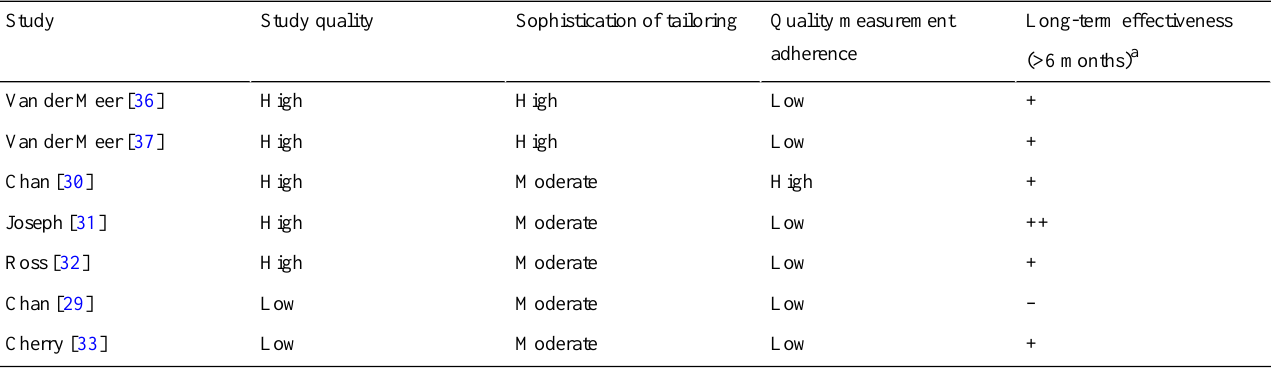
Table 5. Effectiveness of long-term interventions (>6